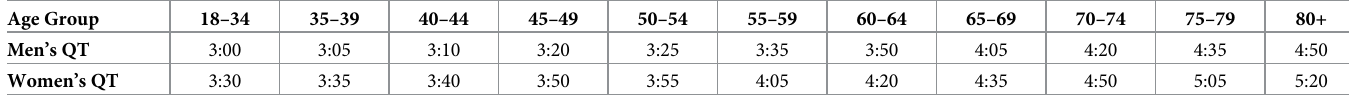
Table 1. 2020 Boston qualifying times. Times are presented in H:MM format. Age